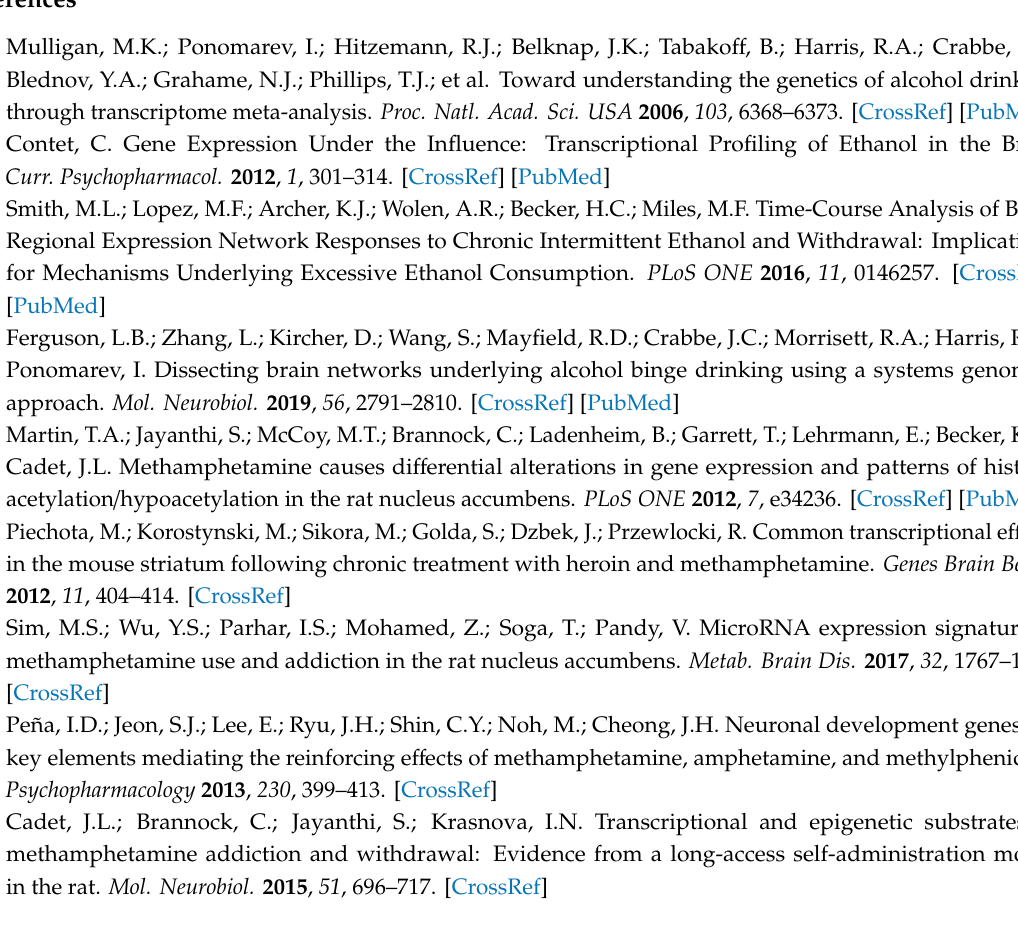
VMB and PFC, and list of glutamatergic synapse genes; Table S9: Di ff erential splicing (DS) in the VMB and associated information; Table S10: GO terms for di ff erential splicing (DS) and network module descriptions; Table S11: Di ff erential wiring (DW) results for cospliced genes; Table S12: GO terms for di ff erential wiring (DW) of cospliced genes and network module descriptions; Table S13: MA-related transcriptome literature; Table S14: Comparison of di ff erential expression (DE) in the VMB of MAHDR vs. MALDR lines using A ff ymetrix microarray 430 2.0 mouse GeneChips [11] and RNAseq data from the current study; Figure S1: Gene–gene coexpression interaction network for di ff erential splicing in the ventral midbrain (VMB), associated with relative genetic risk for MA intake; Figure S2: Gene–gene colocalization interaction network for di ff erential splicing in the ventral midbrain (VMB), associated with relative genetic risk for MA intake; Figure S3: Gene–gene predicted interaction network for di ff erential splicing in the ventral midbrain (VMB), associated with relative genetic risk for MA intake. References [74–98] are cited in Table